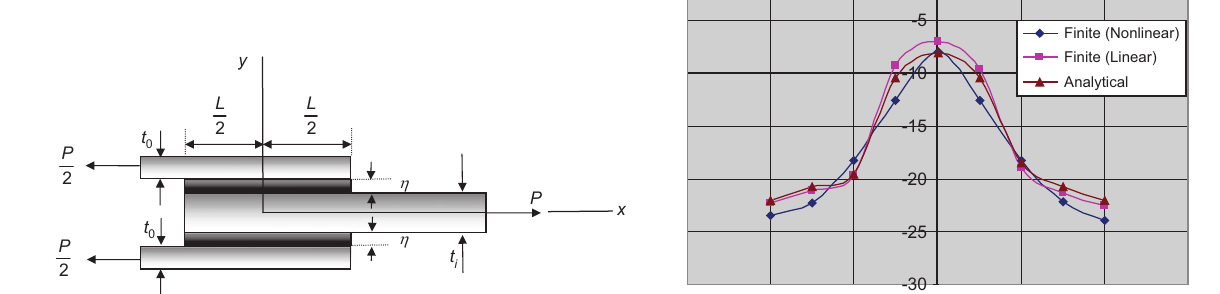
Figure 3 Shear stress along the adhesive for t